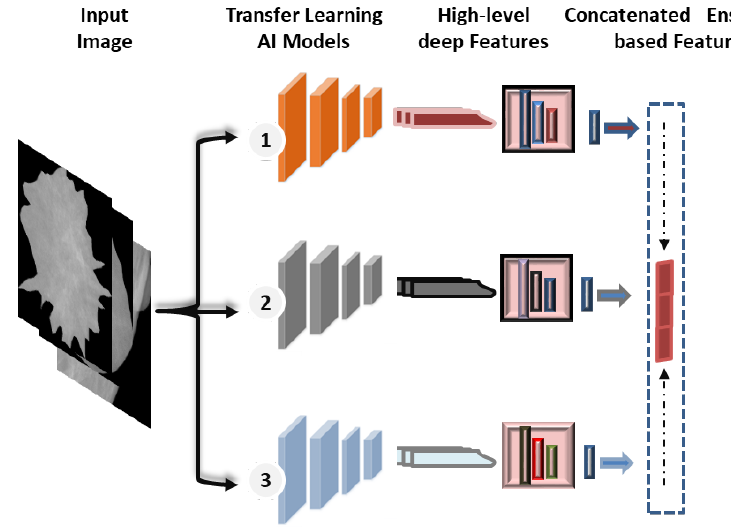
Figure 5. Concatenated ensemble-based features strategy.